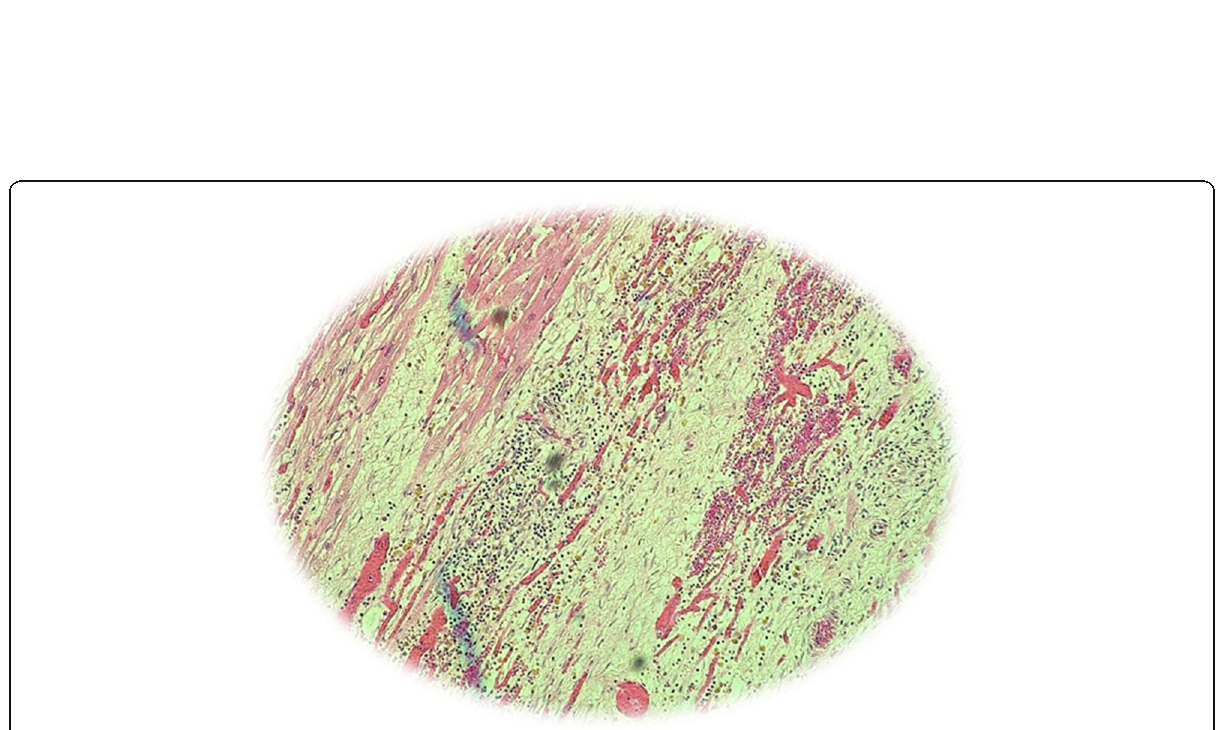
Fig. 5 Histopathological image of the myocardial infarction. Legend: Histopathological analysis showed myocardial hypertrophy, coagulative necrosis with dense infiltration of polymorphonuclear leukocytes, and myocardial scarring from previous infarction (hematoxylin and eosin, ×